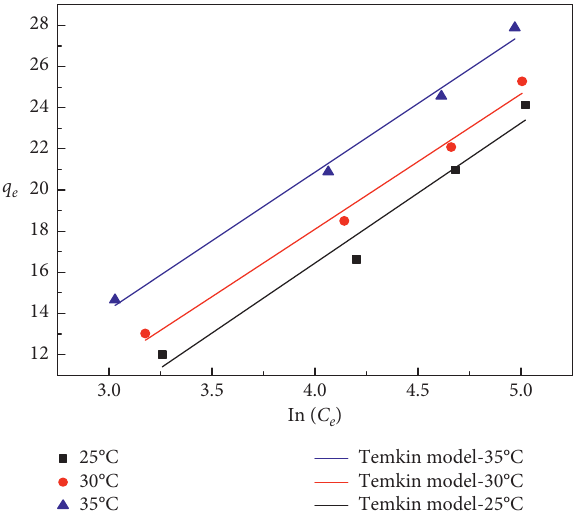
Figure 13: Temkin isotherm plots for the uptake of ammonium on the EMRZ.